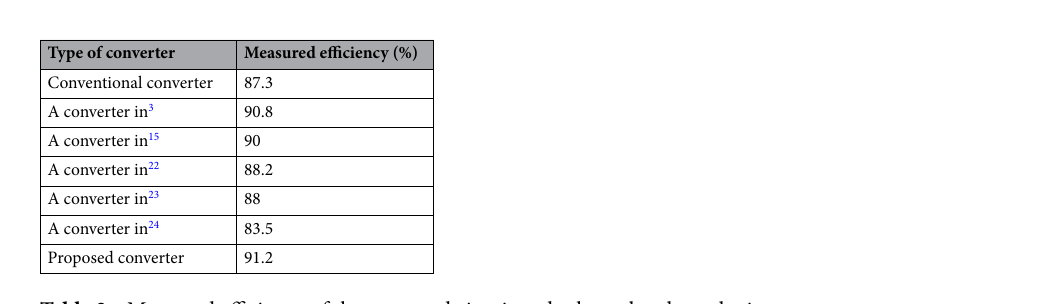
Figure 14. Converter efficiency versus output power at different values of the input voltage and D = 0.4.